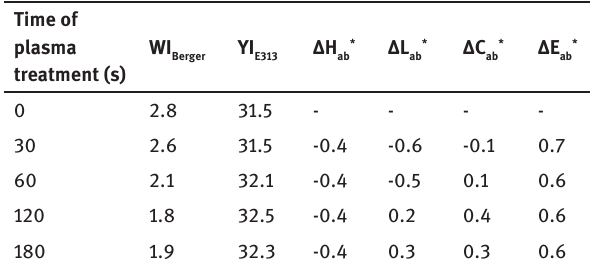
Time of plasma treatment (s)